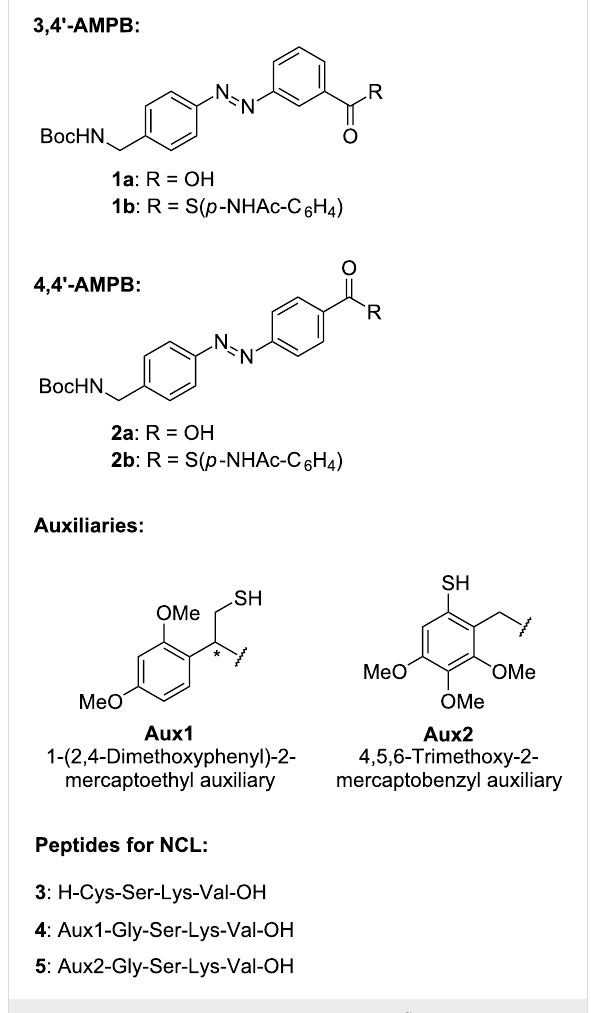
Figure 1: Structures of azobenzene thioesters, N α -ligation auxiliaries and peptides for the application in ligation studies. AMPB = (aminomethylphenylazo)benzoic